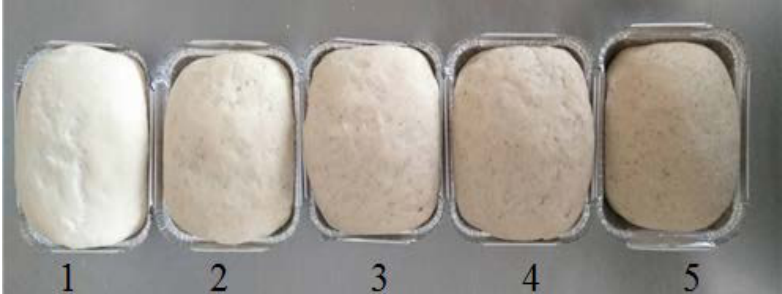
Figure 5. The impact of addition, in different concentrations, of Jerusalem artichoke flour on the quality of the bread (degree of replacement of wheat flour with that of Jerusalem artichoke, %): 1 – control sample, 0%; 2 – 2,5 % 3- 5,0 % ; 4-7,5% ; 5- 10,0%.